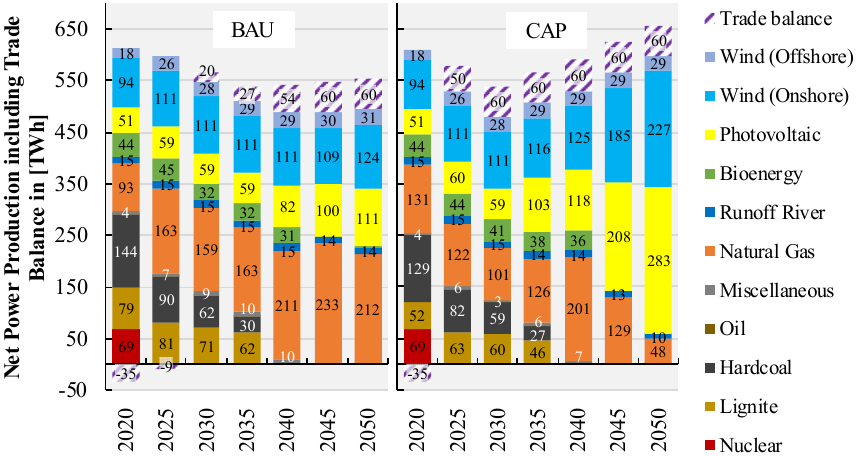
Figure 2. Course of the minimum emission reduction of power production as an exogenous model parameter (GHG emissions cap), derived from the targets of the German government for the total GHG reduction.